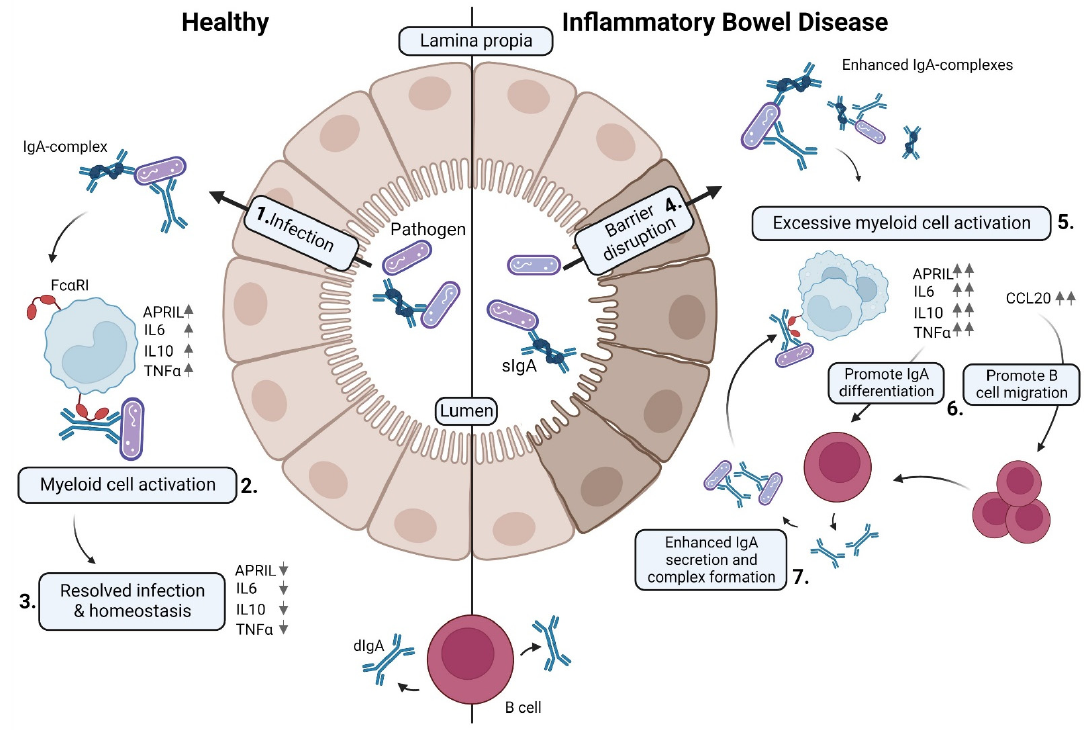
Figure 6. Fc α RI-activated monocytes influence B lymphocyte migration and differentiation. Left panel : (1) During a mucosal infection, dIgA-opsonized bacteria are recognized by myeloid cells and